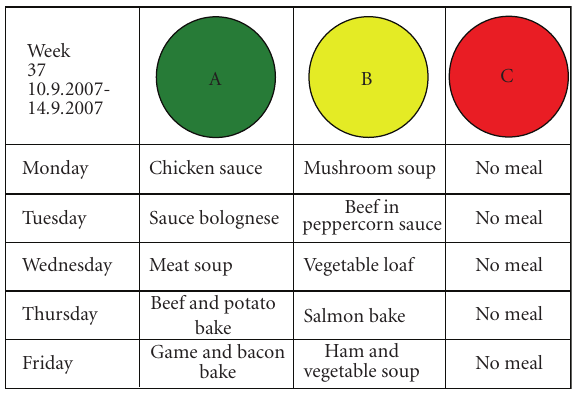
Figure 3: An example of a menu (translated from Finnish).